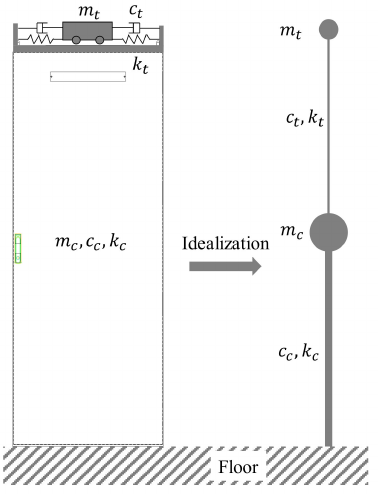
Figure 7. TMD installation concept and